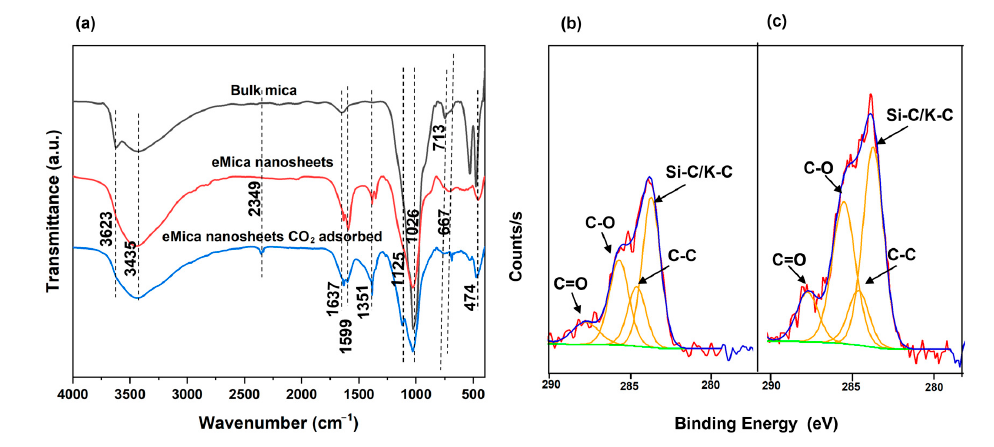
Figure 6. ( a ) FTIR of eMica nanosheets and eMica nanosheets after CO 2 adsorption. XPS analysis of ( b ) eMica nanosheets and ( c ) CO 2 -adsorbed eMica nanosheets.